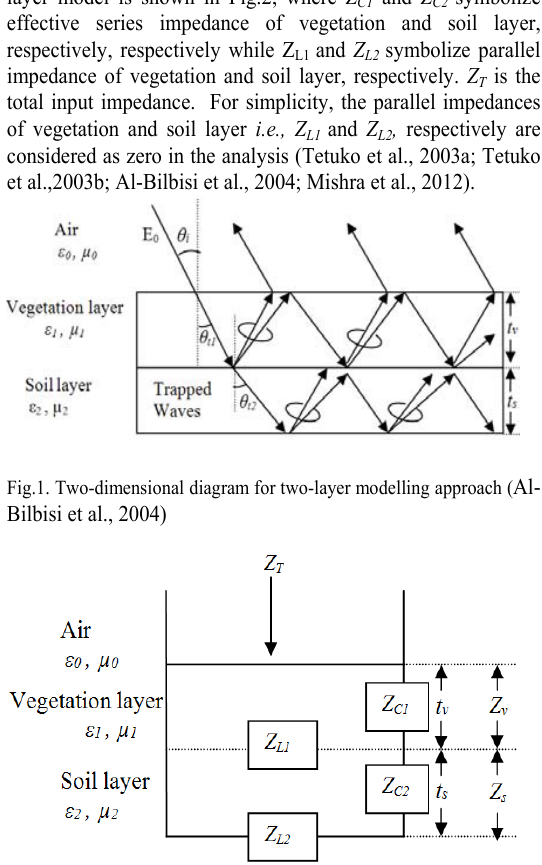
Fig.2. Equivalent circuit of two-layer model ( Al-Bilbisi et al., 2004) Using the concept of transmission line theory,